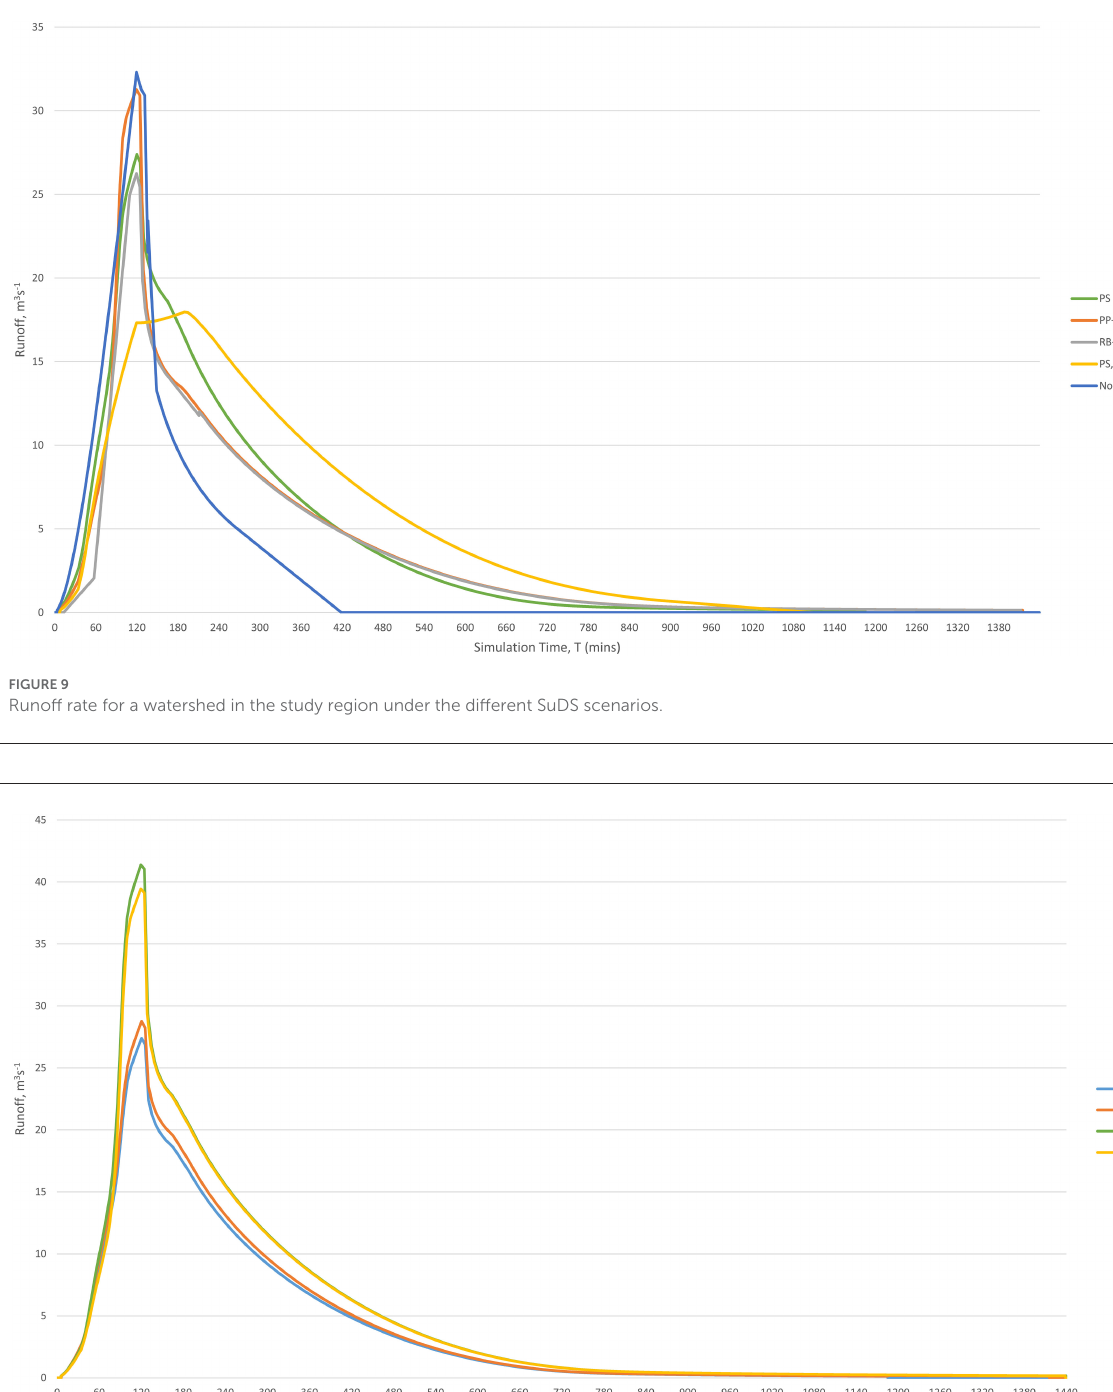
FIGURE10 Runoff rate for a watershed in the study region under the PS scenario and different development approaches.